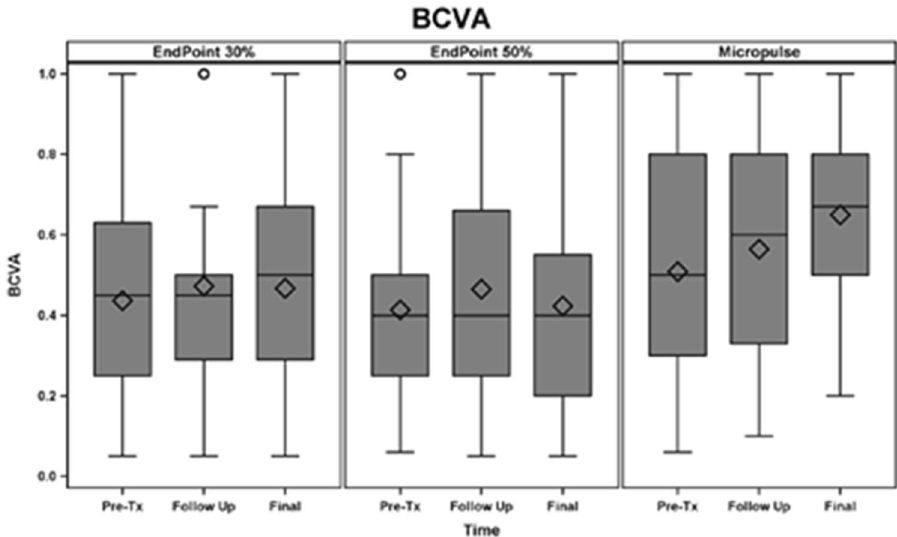
Figure 4. Graphic bar representation of best-corrected visual acuity (BCVA) from baseline (pre-Tx), follow-up (3 months) to the last follow-up (6 months) among three laser treatment groups. Bars represent standard deviations, circles represent statistically significant difference among groups.